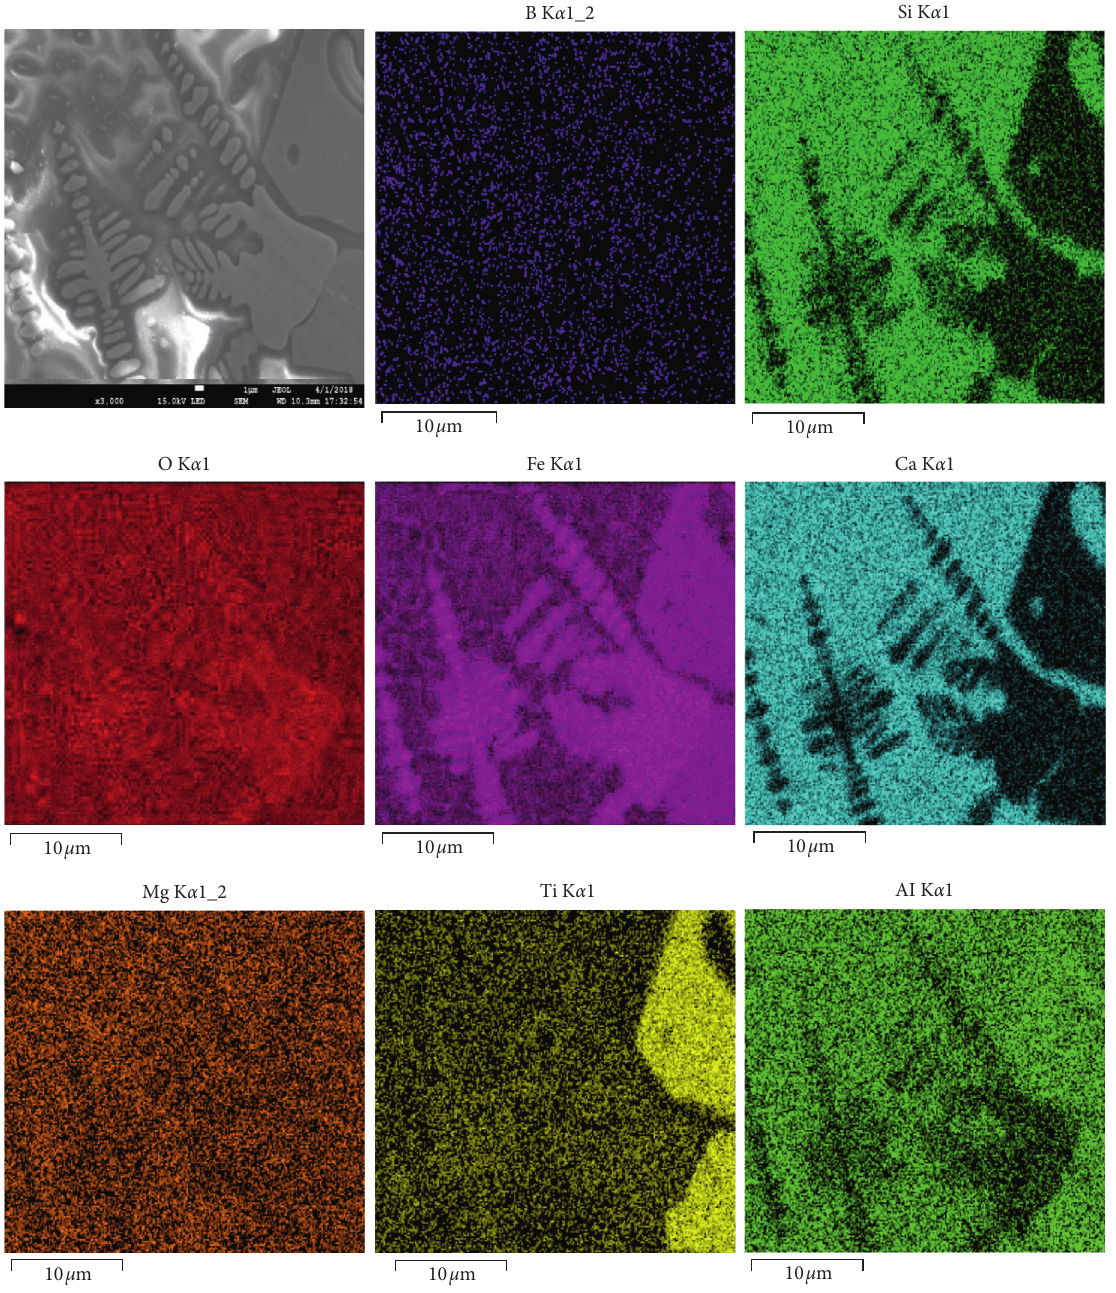
Figure 10: Surface scanning of the H-VTM sample with 5% B